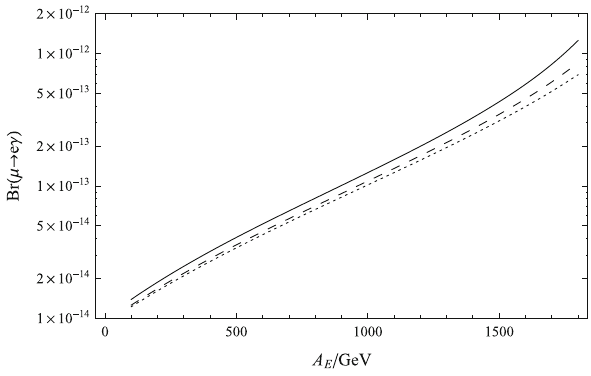
Fig. 10 With μ NL = 0 . 7 ( 1 . 0 , 1 . 3 ) TeV, the branching ratios of μ → e γ versus parameter A E are plotted by the dotted, dashed and solid lines respectively